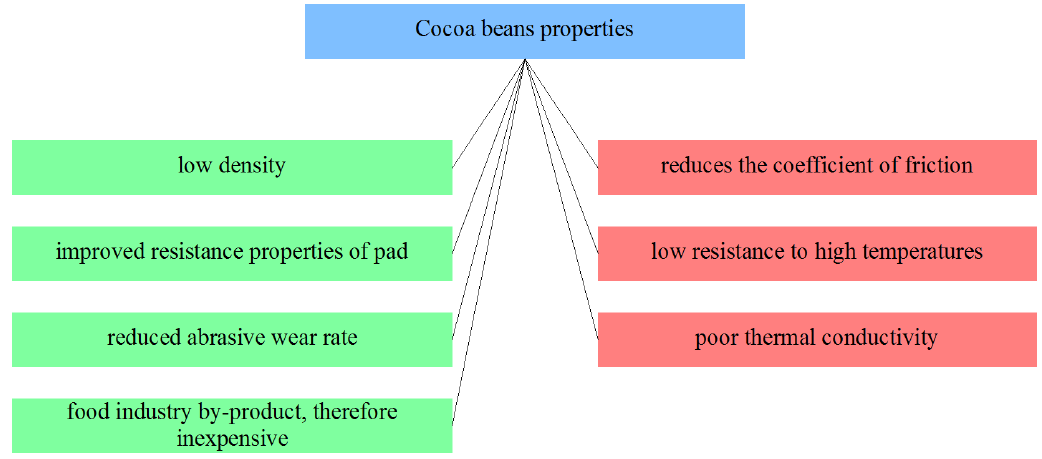
Figure 13: Selected cocoa beans properties from the point of view of applicability in friction